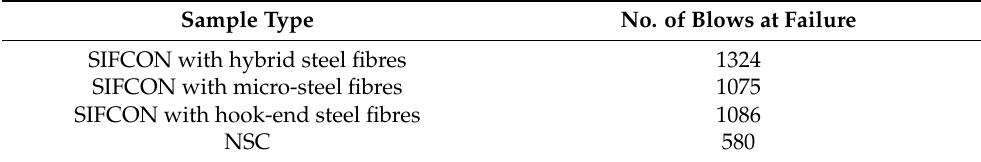
Table 4. Summary of impact loading carrying capacity of SIFCON and NSC slabs with a thickness of 6